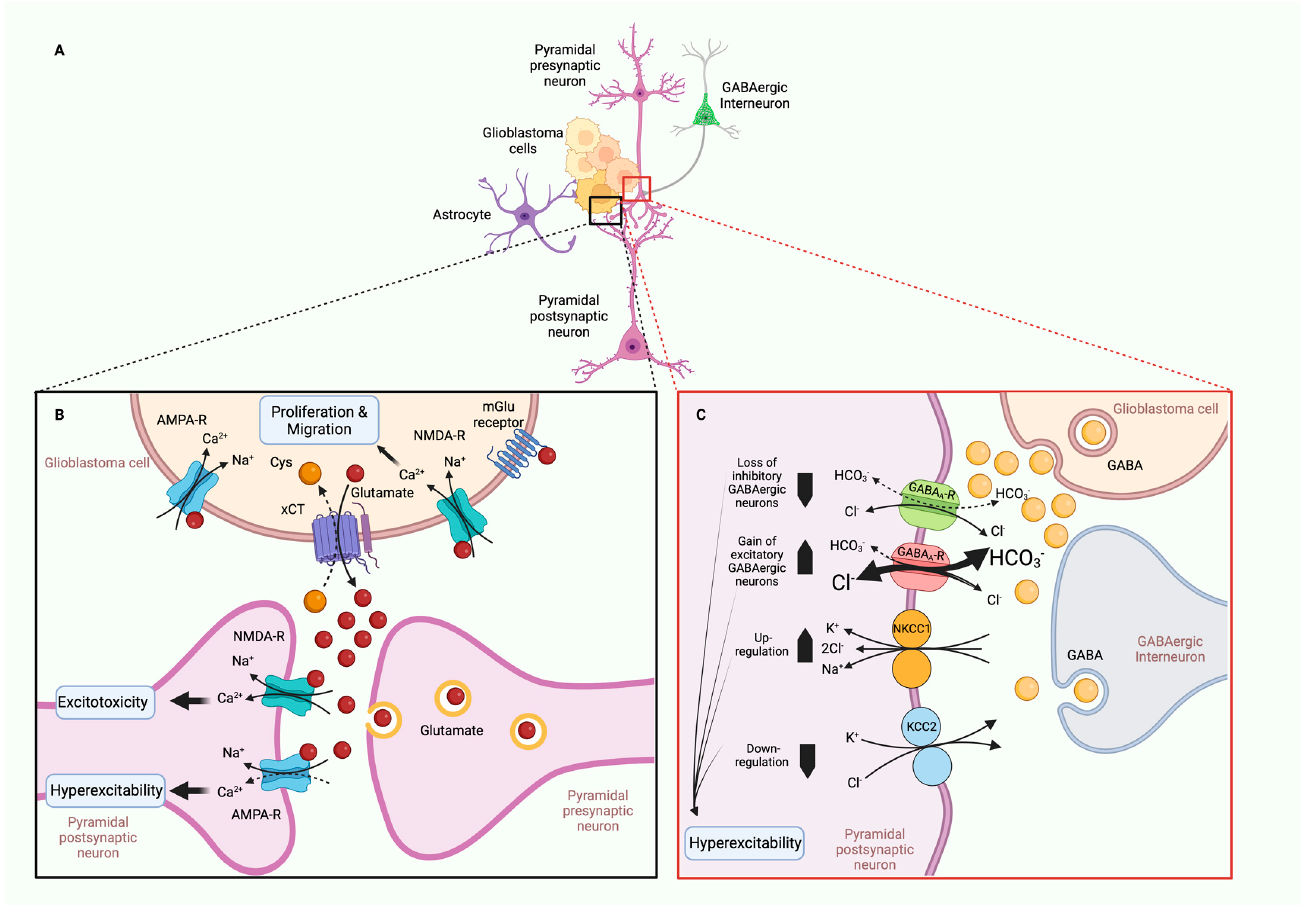
Figure 6. Excitatory and inhibitory networks and their respective neurotransmitter systems also influence the risk of tumor-associated epilepsy (TAE). ( A ) Simplified schematic of glioblastoma cells, cortical neurons, and astrocytes. ( B ) Loss of glutamate homeostasis is a factor in peritumoral seizure activity. Glutamate produced by glioma cells is released in high amounts via the cystine-glutamate transporter (xCT). Binding of glutamate to NMDA and AMPA receptors triggers the opening of cation-specific ion channels that permit influx of Na + or Ca 2+ ions. Elevated extracellular glutamate promotes excitotoxicity in non-tumor parenchyma and creates excitatory imbalance associated with a higher risk of seizures. ( C ) Loss of GABAergic interneurons in peritumoral tissue combined with a reverse GABAergic effect from inhibitory to excitatory in surviving neurons creates a hyperexcitable tumor microenvironment with increased seizure susceptibility. Downregulation of chloride exporter KCC2 and upregulation of chloride importer NKCC1 leads to excessive intracellular chloride concentrations and causes GABA-mediated depolarization and hyperexcitability. Created with BioRender.com.